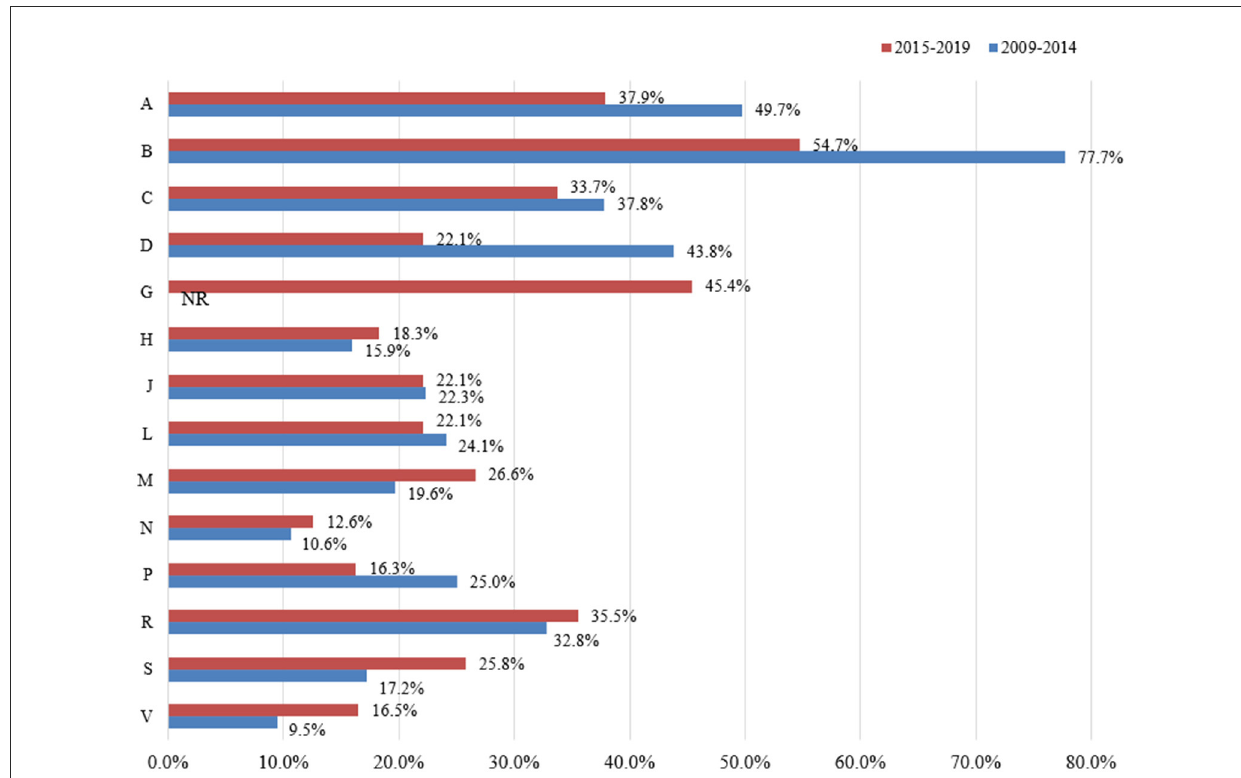
FIGURE4 Changes in the availability of essential medicines between different categories based on ATC (2009–2014 vs. 2015–2019). G: Not reported the availability of Genito urinary system and sex hormones from 2009 to 2014. A: Alimentary tract and metabolism; B: Blood and blood forming organs; C: Cardiovascular system; D: Dermatologicals; G: Genito urinary system and sex hormones; H: Systemic hormonal preparations, excl. sex hormones and insulins; J: Antiinfectives for systemic use; L: Antineoplastic and immunomodulating agents; M: Musculo-skeletal system; N: Nervous system; P: Antiparasitic products, insecticides and repellents; R: Respiratory system; S: Sensory organs: V: